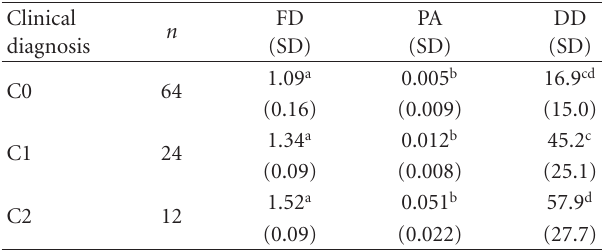
Table 1: FD, PA, and DD of each clinical